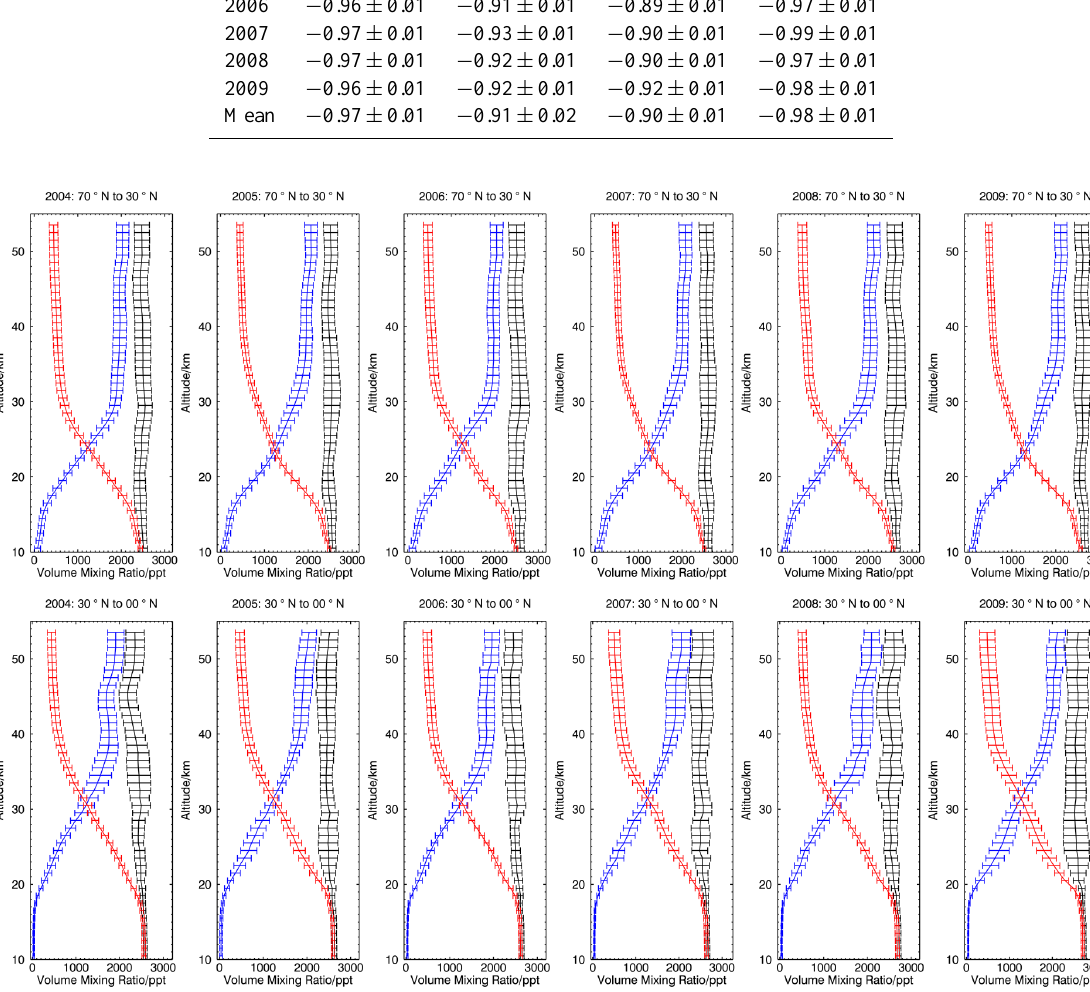
Fig. 1. The fluorine budgets from 2004 to 2009 in latitude band 30–70 ◦ N and 0–30 ◦ N (black). The inorganic (blue) and organic (red) fluorine profiles are also shown. The error bars are the result of combinations of standard deviations of the mean profiles of the relevant fluorine-containing species. Systematic retrieval errors are not known at this time and therefore are not included in these errors.